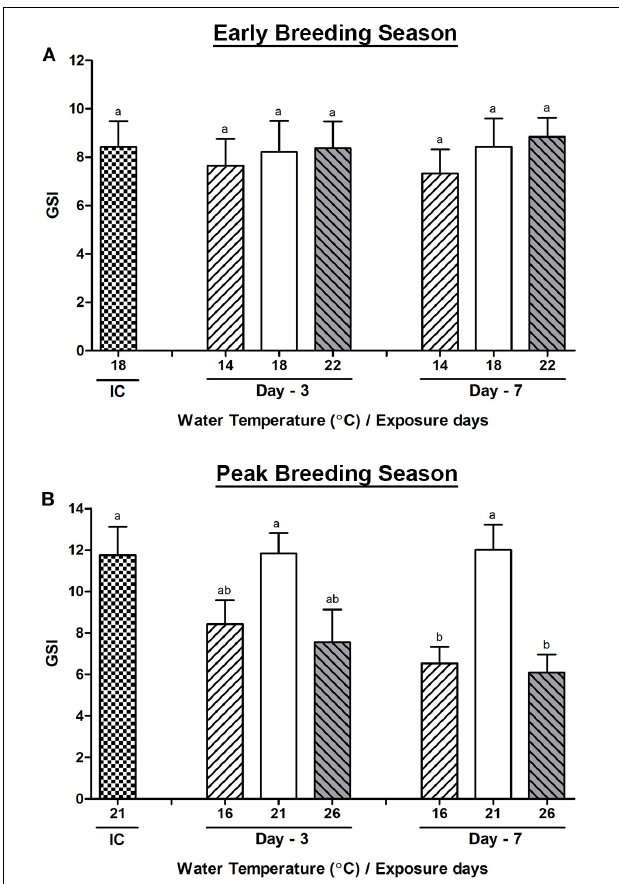
FIGURE 1 | Changes in the gonadosomatic index (GSI) of male Pacific abalone during early (A) and peak (B) breeding seasons exposed to thermal stress for 7 days. Before exposure to the target temperature of thermal stress, abalone were sampled to obtain reference values that served as initial control (IC). Values represent the mean ± SD ( n = 10). Different letters on the bar indicate significant differences among different temperature groups ( p <